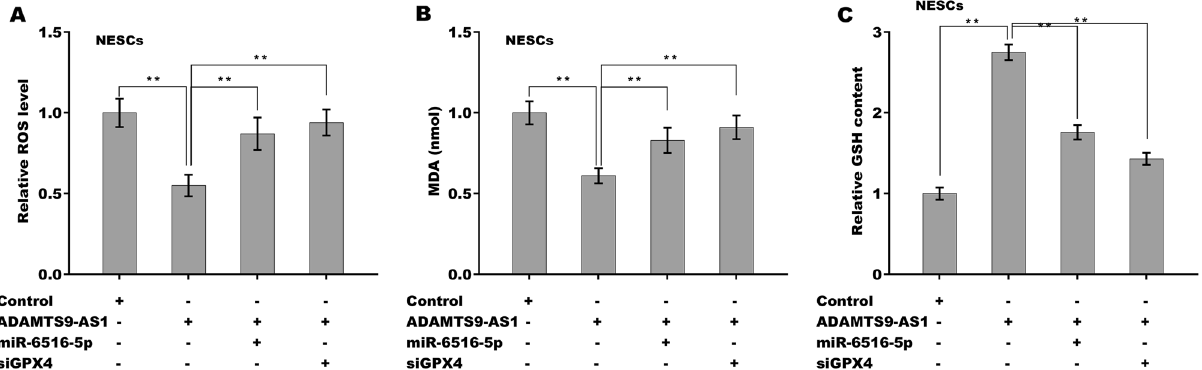
Figure 7. The effect of the ADAMTS9-AS1/miR-6516-5p/GPX4 axis on ferroptosis. The ROS levels ( A ), MDA content ( B ), and GSH content ( C ) were assessed in NESCs after ADAMTS9-AS1 overexpression in the presence or absence of miR-6516-5p or siRNA-Gpx4. ** p <